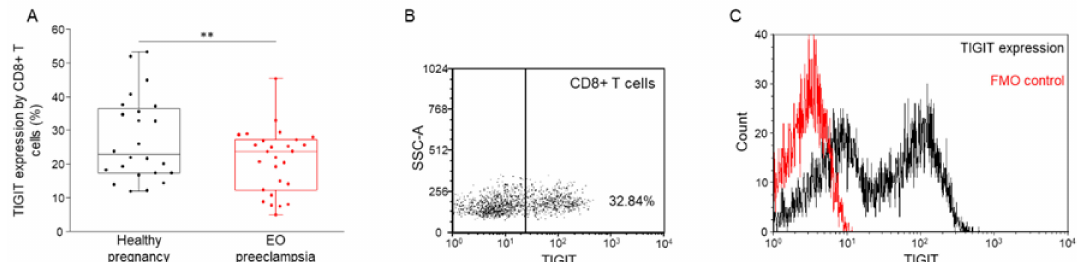
Figure 2. TIGIT expression by CD8+ cytotoxic T cells in women with EO preeclampsia and healthy pregnant women. The expression of TIGIT by CD8+ cytotoxic T cells in the peripheral blood of women with EO preeclampsia and healthy pregnant women ( A ). The solid bars represent medians of 24 and 27 determinations, respectively, the boxes indicate the interquartile ranges, and the lines show the most extreme observations. Differences were considered statistically significant for p -values < 0.05 **. Representative FACS plots show the expression of TIGIT surface marker by CD8+ T cells ( B ). To determine the positivity of the TIGIT receptor, fluorescent minus one (FMO) control was used ( C ).